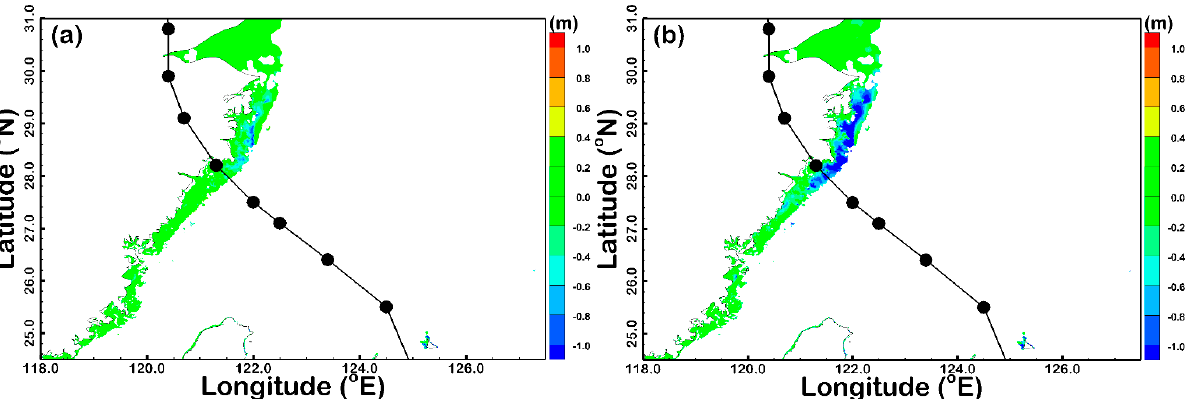
Figure 18. Spatial distribution of the difference in maximum SWH between the scenarios of ( a ) S_NO1 and S_NO2 and ( b ) S_NO1 and S_NO3 when Super Typhoon Lekima (2019) made landfall on the southeast coast of China. The areas with water depths greater than − 20 m are shown.